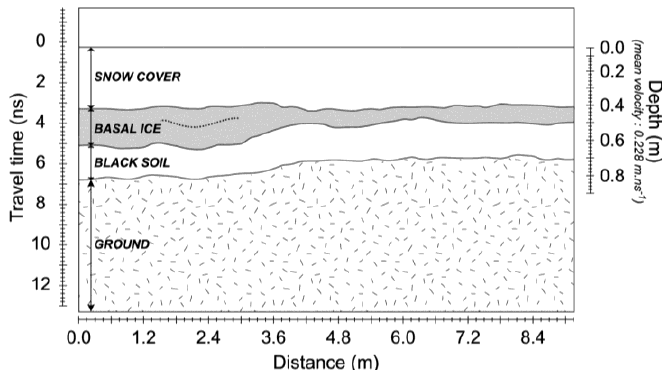
Figure 8. An interpretation of a high-frequency (900 MHz) GPR reflection profile at the sedge fen site (SI), 24 March